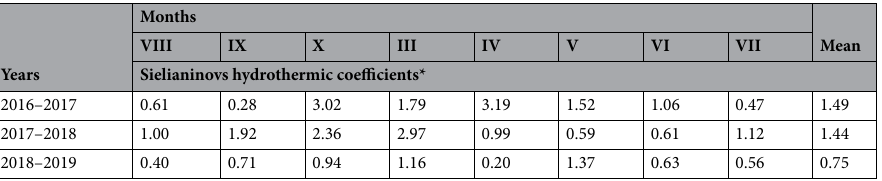
Table 2. Characteristics of weather conditions in the years 2016–2019 (Zawady Meteorological Station, Poland). *Index value 33 : extremely dry k ≤ 0.4. very dry 0.4 < k ≤ 0.7. dry 0.7 < k ≤ 1.0. rather dry 1.0 < k ≤